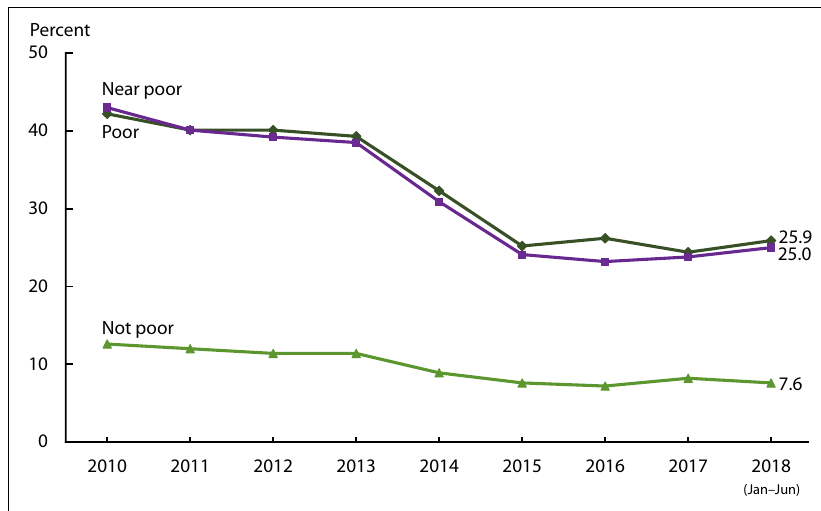
Figure 4. Percentage of adults aged 18 – 64 who were uninsured at the time of interview, by poverty status: United States, 2010–June